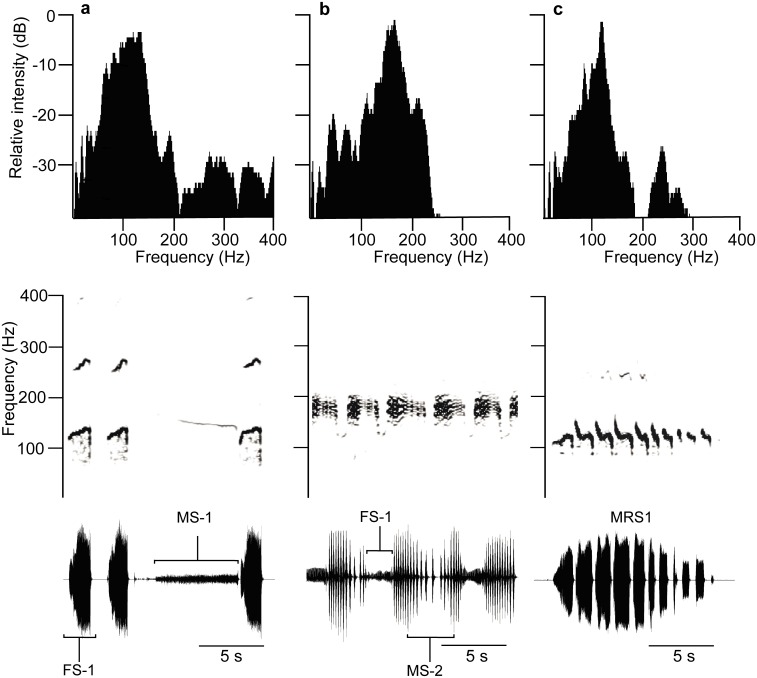
Spectra (upper), sonograms (middle) and oscillograms (lower) of Eushistus heros vibratory communication signals.a: FS-1 and MS-1 pulses in a calling duet, b: FS-1 pulses and MS-2 pulse trains in a courtship duet, c: MRS pulse train.